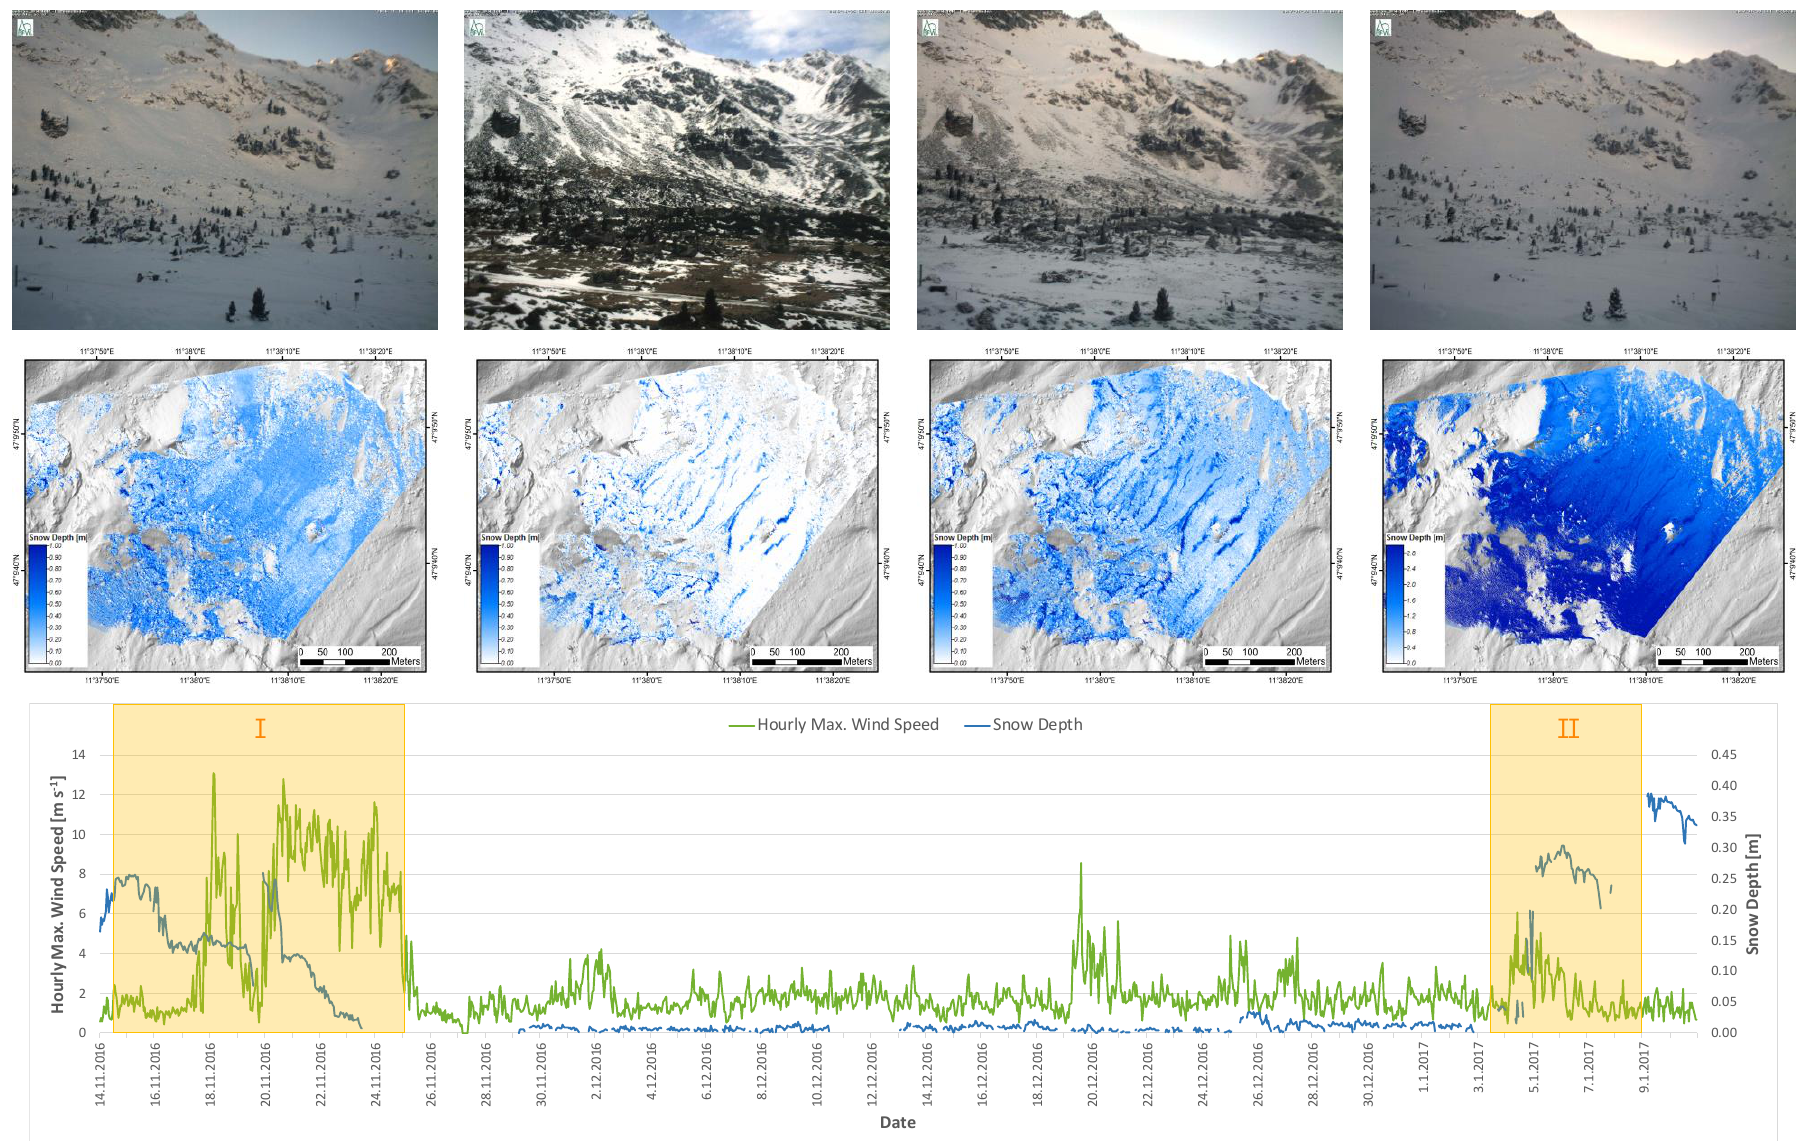
Figure 3. Monitoring snow drift at the study site during two observation periods; webcam images from start and end of each period (top row); corresponding ATLS-based HS-maps (centre row)